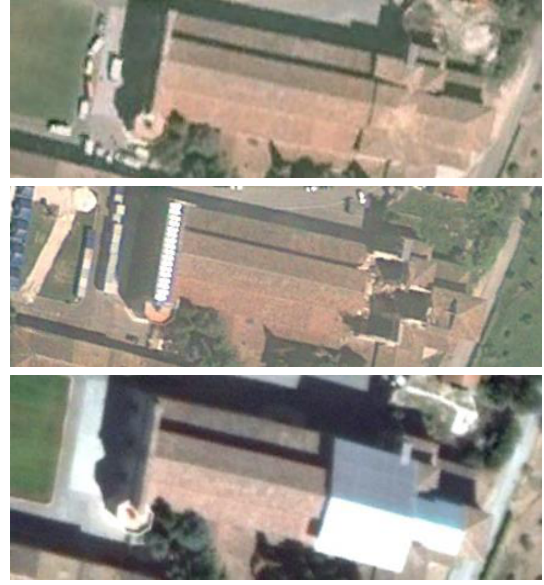
Fig. 2. Some Google Earth images acquired in 2006, 2009 (after the earthquake), and 2011.